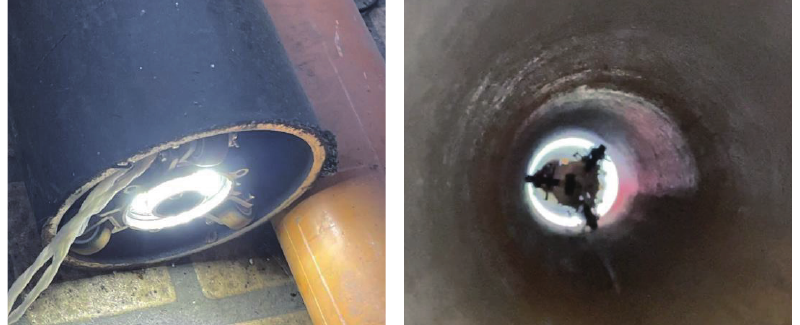
Figure 16. Experimental set-up.